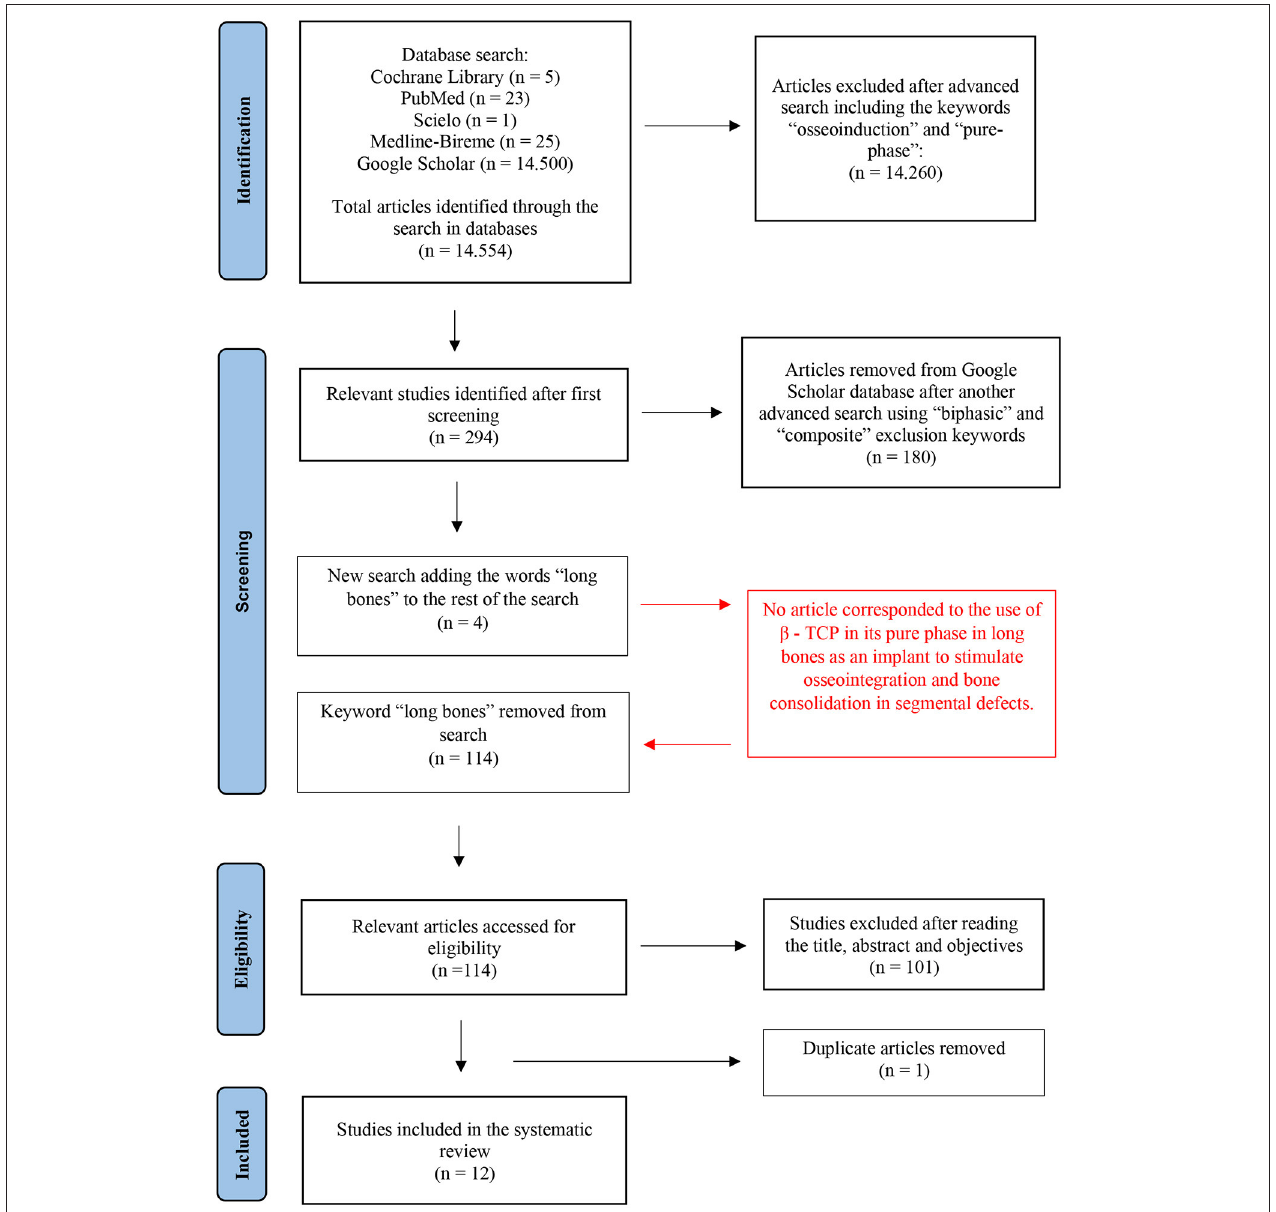
FIGURE 1 | PRISMA flowchart of the search strategy for the data collected for inclusion and exclusion of articles in the systematic